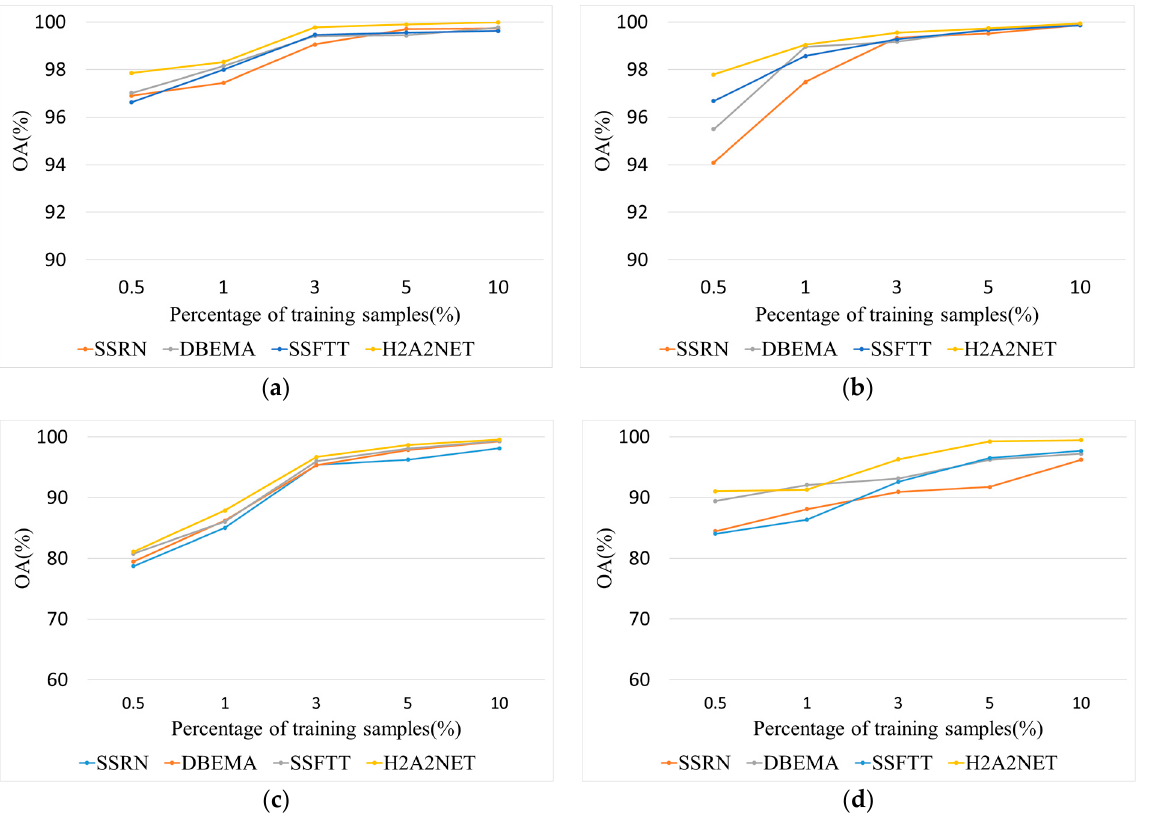
Figure 13. OAs with different training percentages of datasets. ( a ) UP. ( b ) SV. ( c ) HOU. ( d ) KSC.